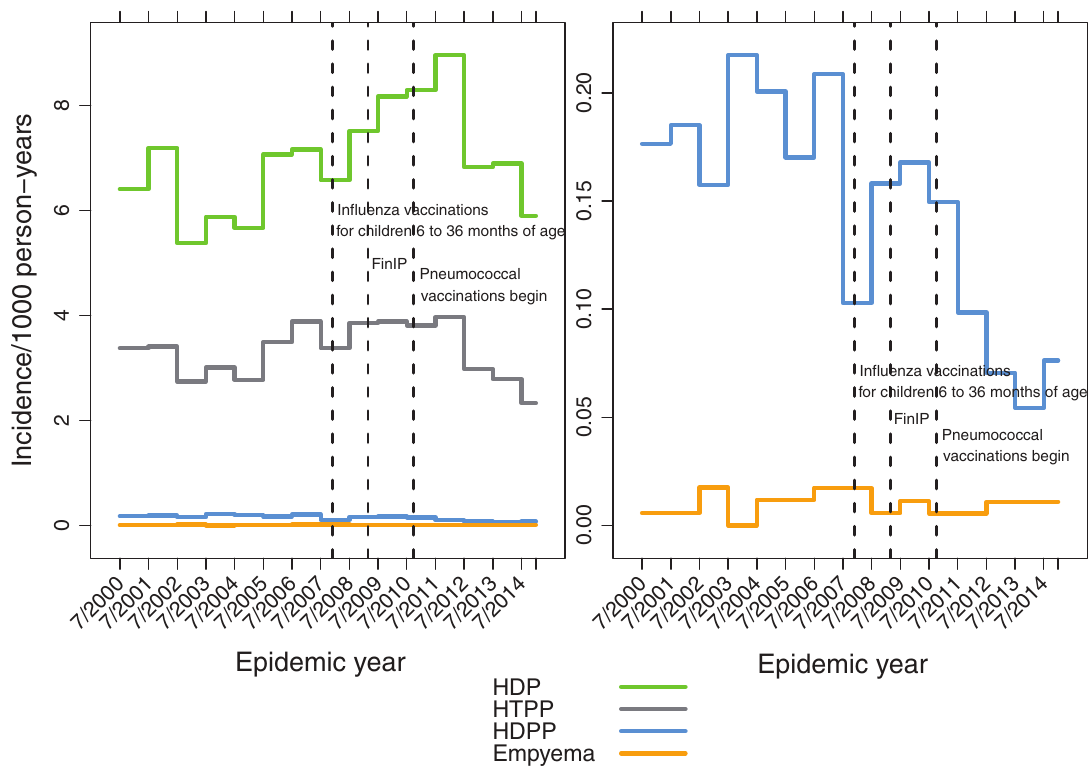
Fig 5. Annual pneumonia rates in children 2 to 4 yearsof age by epidemic years. A) all pneumonia outcomes, HDP hospital-diagnosedpneumonia,HTPP hospital-treated primary pneumonia, HDPP hospital-diagnosedpneumococcal pneumoniaand empyema; B) HDPP and empyema on different scale.